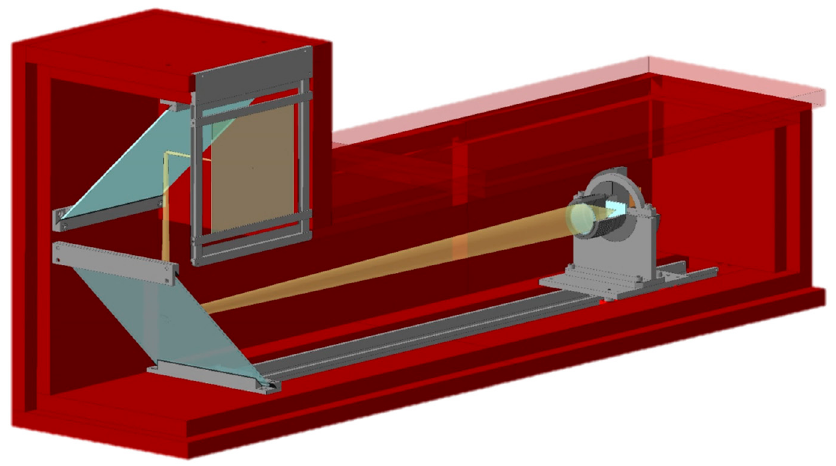
Figure 2. Scheme of the detector system used on the neutron radiography and tomography facility on the IBR-2 reactor. Firstly, the neutron radiation is converted into light photons by a scintillator plate. The scintillator thickness is 100 µm. The light from the scintillator is reflected by the mirrors, and then directed to the optical system of the high resolution and high sensitive CCD-based video camera.